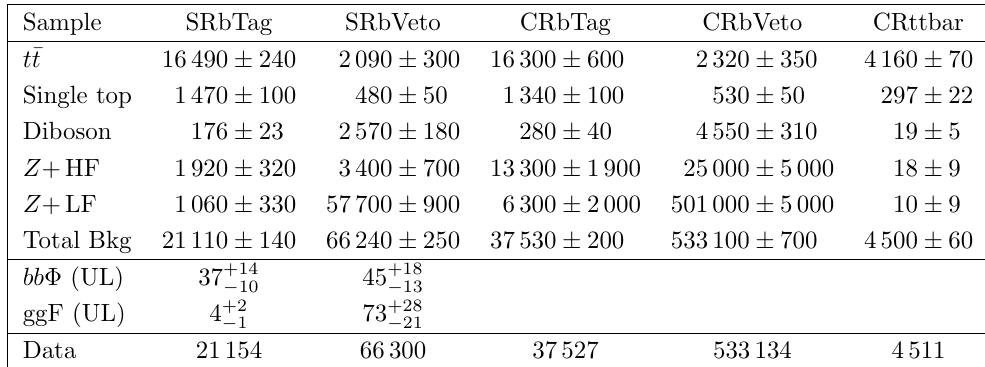
Table 2 . Post-(cid:12)t numbers of events from the combined (cid:12)t under the background plus signal hy- pothesis (480 GeV bb (cid:8) signal). Here \Total Bkg" represents the sum of all backgrounds. The quoted uncertainties are the combination of statistical and systematic uncertainties. The uncertainty in the total background determined by the (cid:12)t is smaller than the sum in quadrature of the individual components due to the normalization factors and systematic uncertainties that introduce correlation between them. The number of signal events corresponds to the expected upper limit (UL) times the cross-section. The uncertainties in the expected signal yields are from (cid:12)ts using the Asimov dataset.